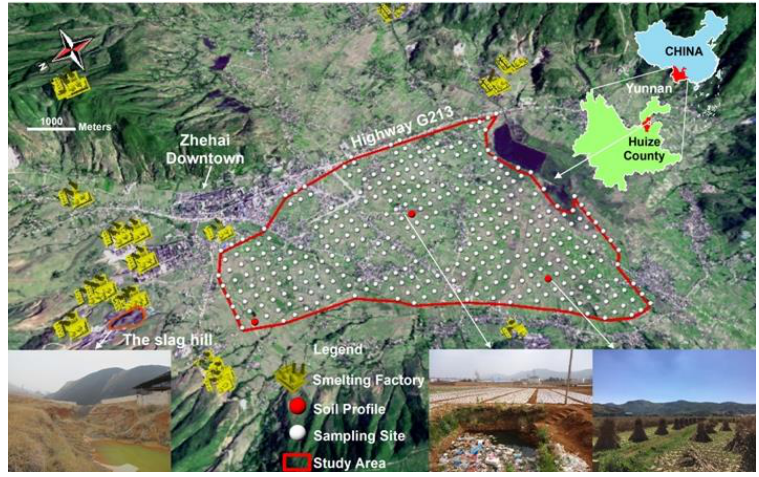
Figure 1. Map of the study area and location of the sampling sites in Zhehai, Yunnan Province, China.